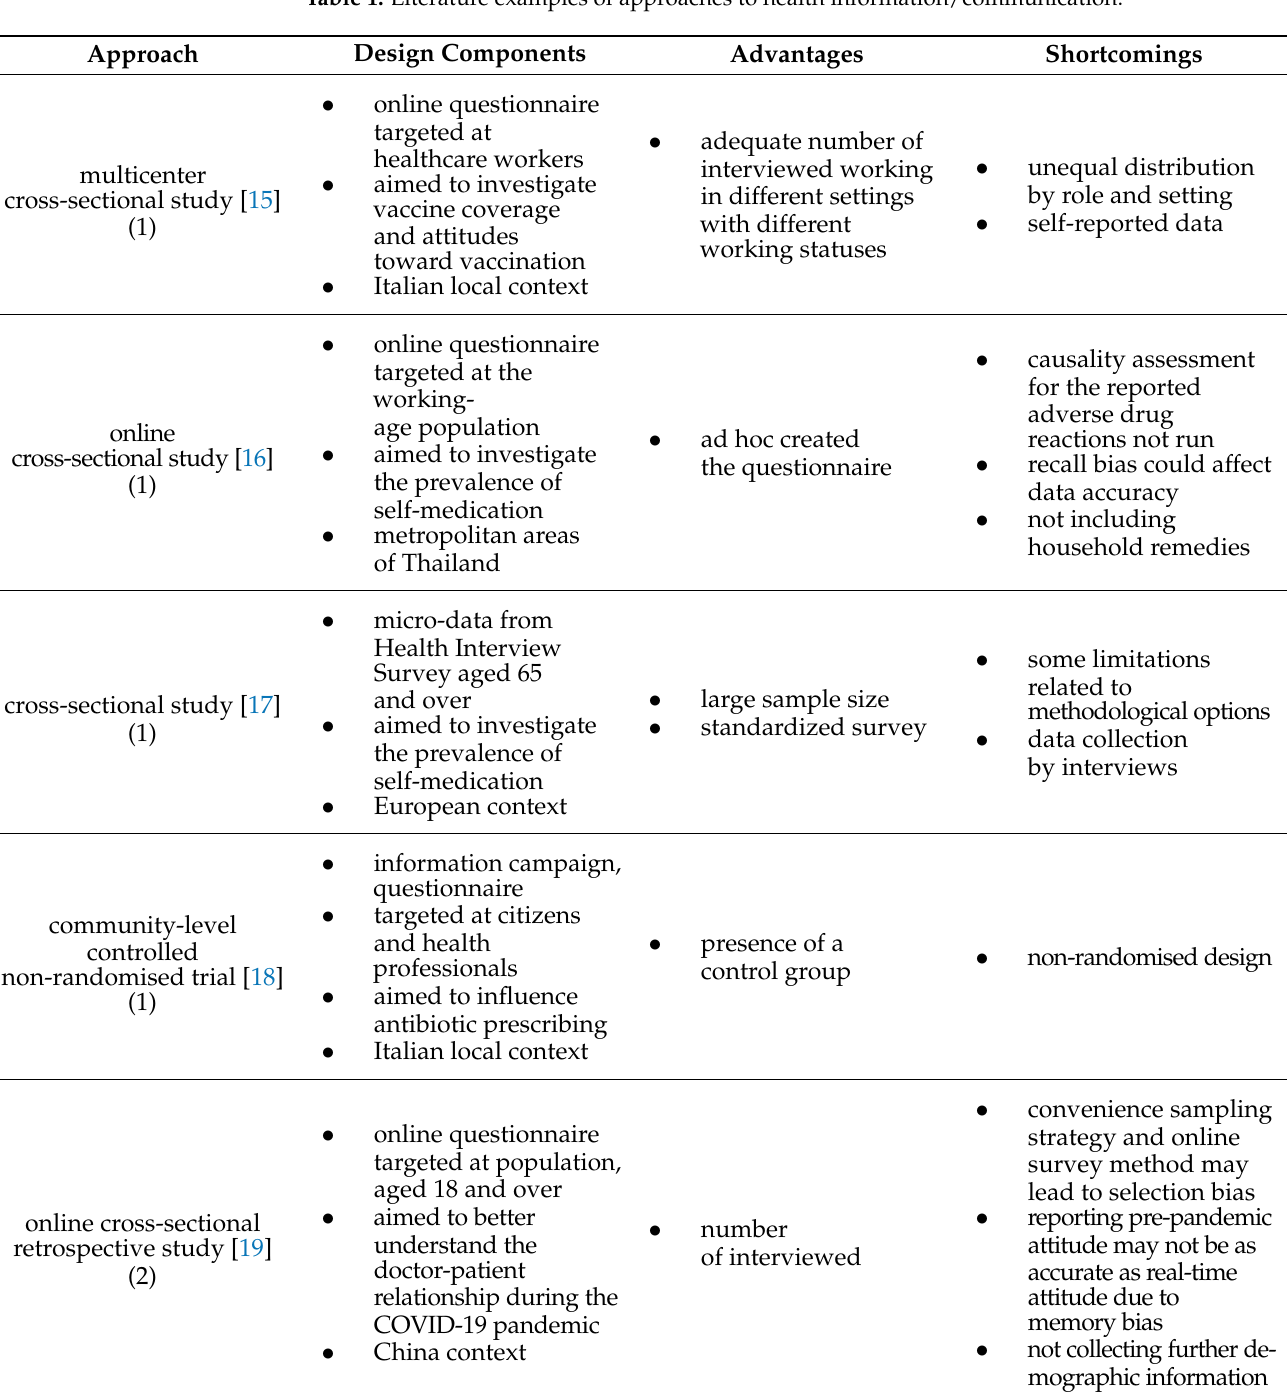
Table 1. Literature examples of approaches to health